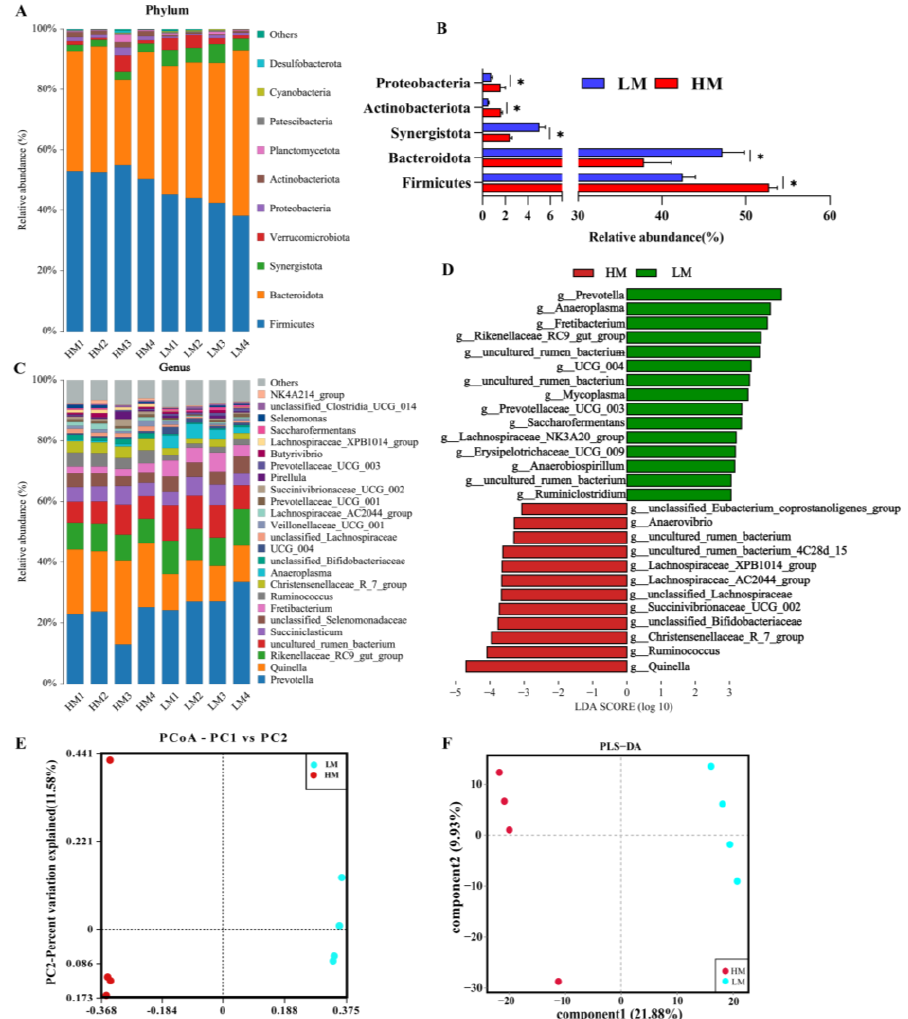
Figure 4. Rumen microbial composition and diversity between LM and HM groups of sheep. ( A ) Taxonomic composition of rumen microorganisms at the phylum level between the two groups. ( B ) Significantly differentiated microbes at the phylum level (* p < 0.05, determined by Wilcoxon rank- sum test). ( C ) Taxonomic composition of rumen microorganisms at the genus level between the two groups (1%, according to relative abundance). ( D ) LEfSe analysis at the genus level (LDA > 2). ( E ) PCoA analyses based on Bray − Curtis distance. ( F ) Analysis of the ruminal microbiota using PLS- DA. LM, low − motility group; HM, high − motility